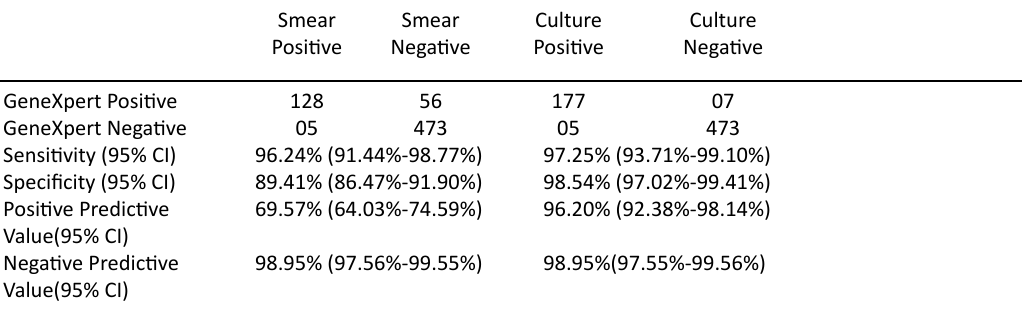
Table 1. Comparison between smear microscopy, GeneXpert and MGIT 960